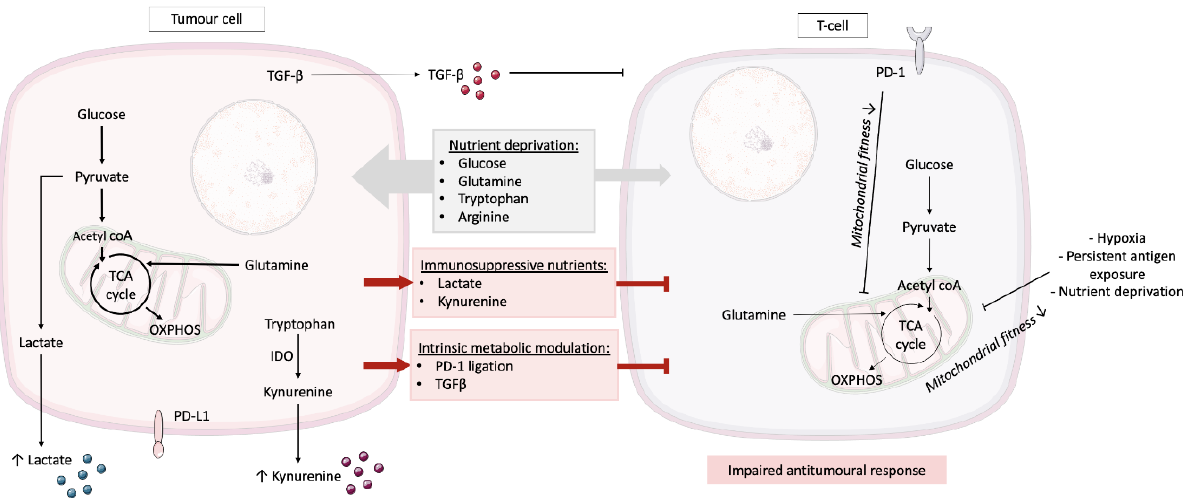
Figure 1. T cell metabolism and the tumour microenvironment. T cells face various metabolic challenges within the TME. Direct competition for nutrients arises such as glucose, glutamine, and amino acids, with the tumour outcompeting T cells. The tumour can also produce immunosuppressive nutrients such as lactate and kynurenine, and intrinsically modulate T cell metabolism through PD-1 checkpoint ligation and the production of TGF- β . This metabolic modulation of T cells within the TME results in an impaired anti-tumoural response. IDO, indoleamine 2,3-dioxygenase; OXPHOS, oxidative phosphorylation; PD-1, programmed cell death-1; PD-L1, programmed cell death-ligand 1; TCA cycle, tricarboxylic acid cycle; TGF- β , transforming growth factor-beta; and TME, tumour microenvironment.